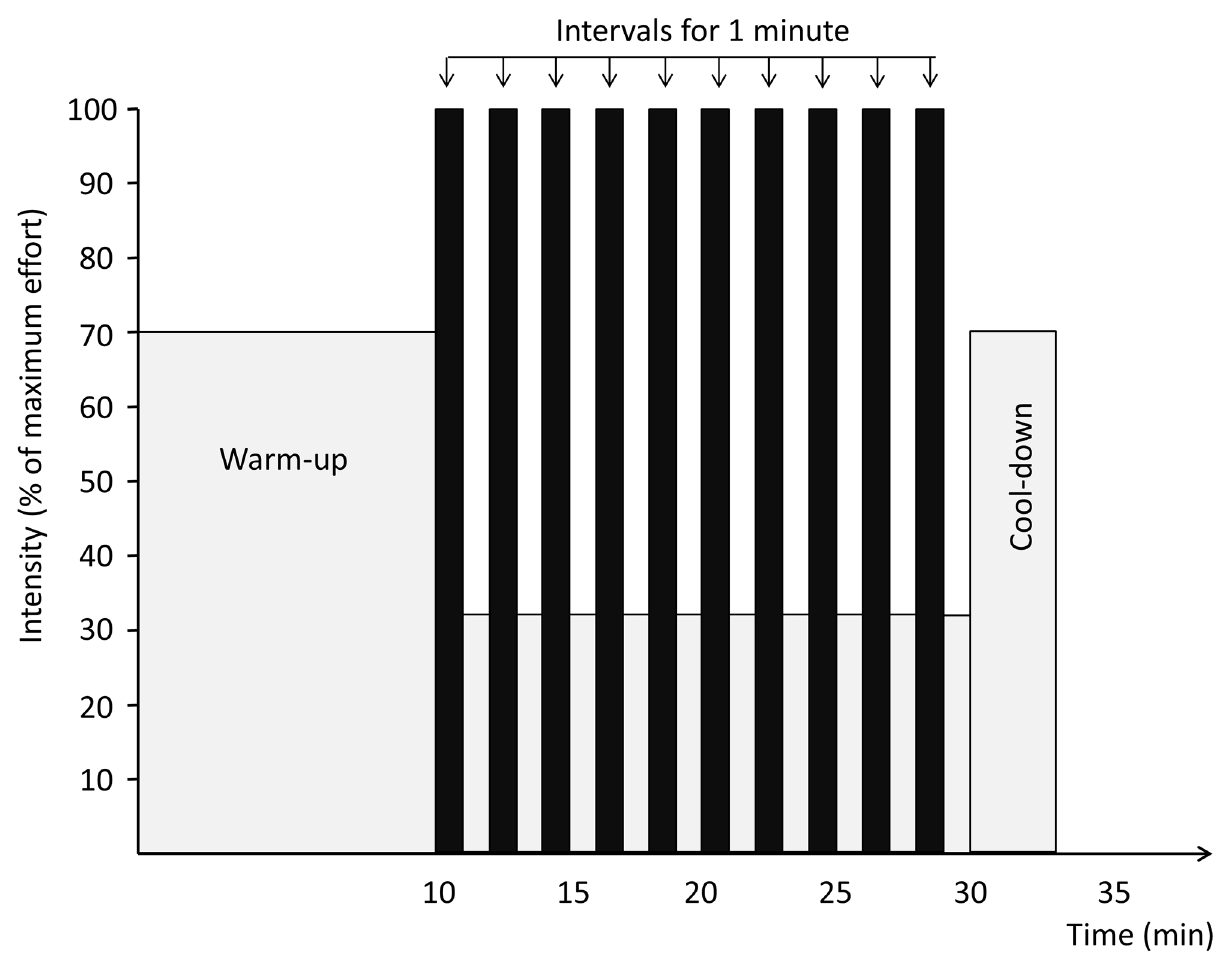
Fig 3. Ten times one minute high intensity interval